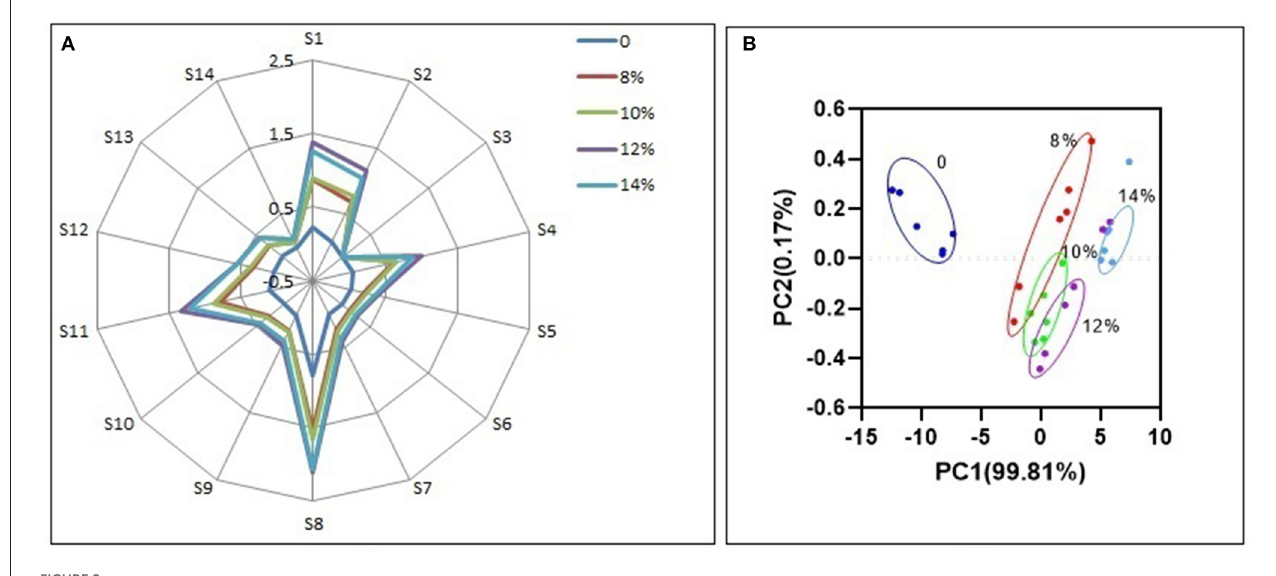
FIGURE8 Odor response value of electronic nose (A) and PCA (B)